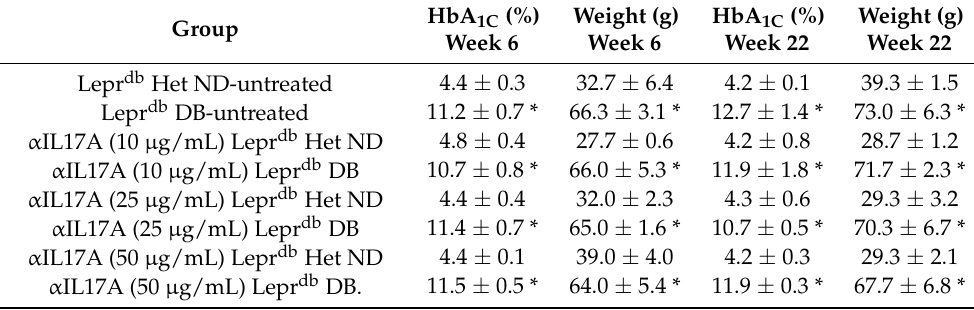
Table 3. Clinical data of db/db diabetic mice receiving intraperitoneal injections of anti-IL-17A.